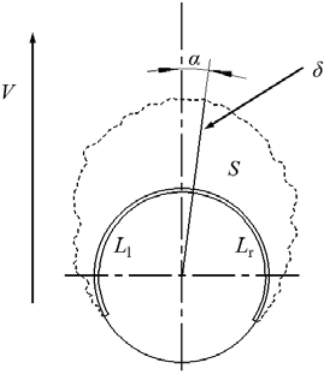
Figure 8. Typical parameters characterizing features of icing on a rotating cylinder. As shown in Figure 8, typical parameters include the icing area S , the stagnation point thickness δ , the stagnation point deflection angle α , the left icing limit L l and the right icing limit L r . The icing area S characterizes the area of the ice layer covering on the cylinder surface. The stagnation point thickness δ is the vertical distance from the highest point on the ice layer to the cylinder surface. The stagnation point deflection angle α is the included angle between the vertical center line and the straight line distance from the stagnation point to the center point of the cylinder. The rotation direction of the cylinder is the same as the deflection direction of the stagnation point deflection angle, and the linear velocity V is shown in Figure 8. With regard to the circumferential velocity of the cylinder, the clockwise direction is positive and the counterclockwise direction is negative. The parameter L 1 is the left icing limit, which is the arc length covered by the ice layer on the left half. Similarly, the parameter L r is the right icing limit.